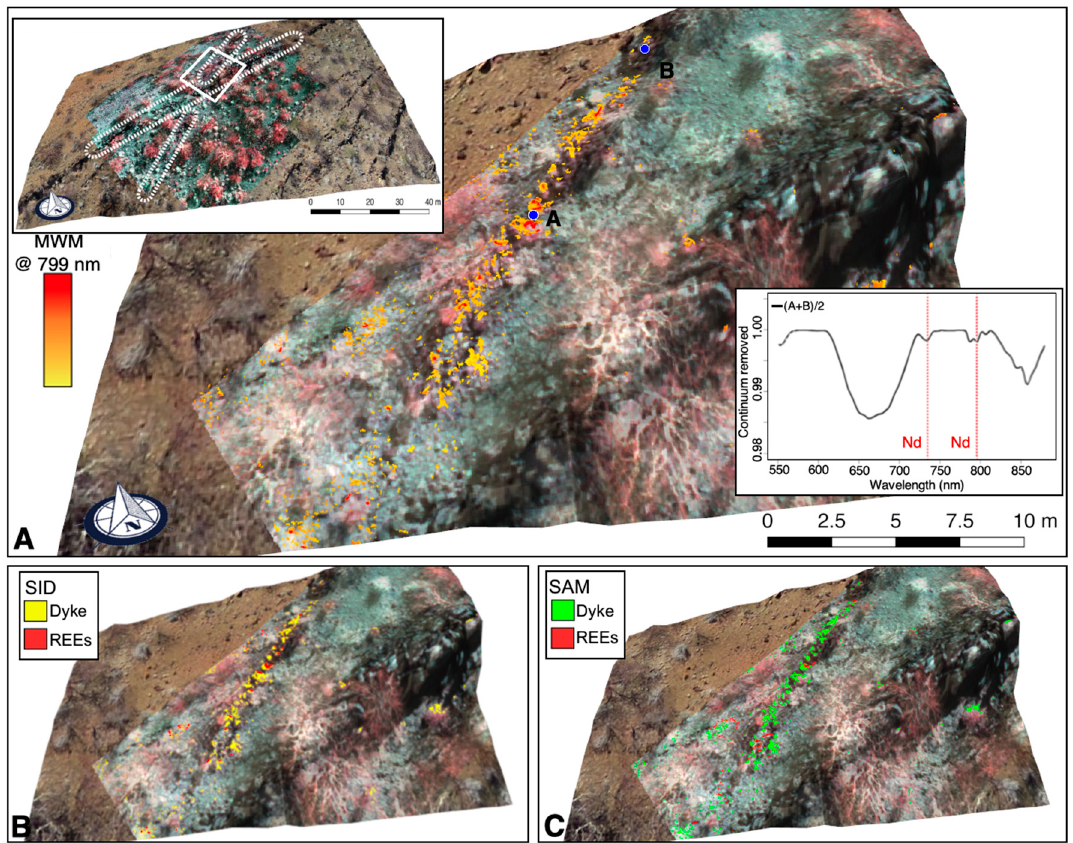
Figure 13. ( A ) Result of MWM on a selected section of D1 with an inset of the entire Rikola image indicating the locations of the two dykes. Pixels in red contain a deep absorption feature at 799 nm while yellow pixels do not contain an absorption feature. The displayed spectrum shows Nd absorption features, which is the result of averaging the spectra measured at points A and B and was used as reference spectra for SAM and SID. ( B ) SID result, indicating pixels in red as spectrally similar to REE-hosting rocks. ( C ) SAM result, indicating pixels in red as spectrally similar to REE-hosting rocks.